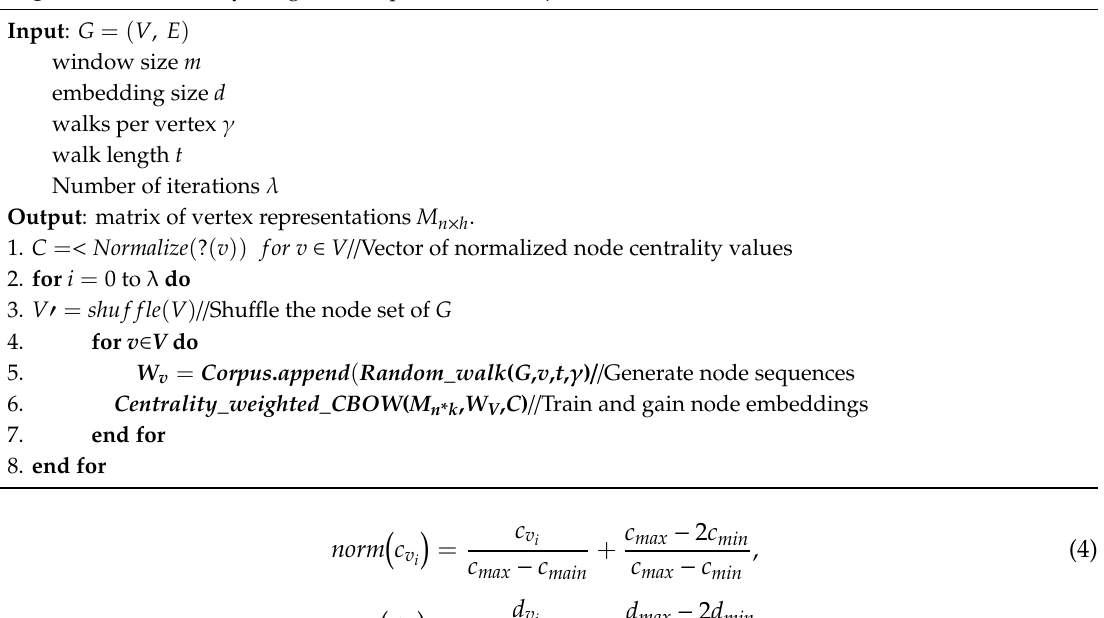
Algorithm 1 . Centrality-weighted DeepWalk ( G , m , d , γ , t , λ